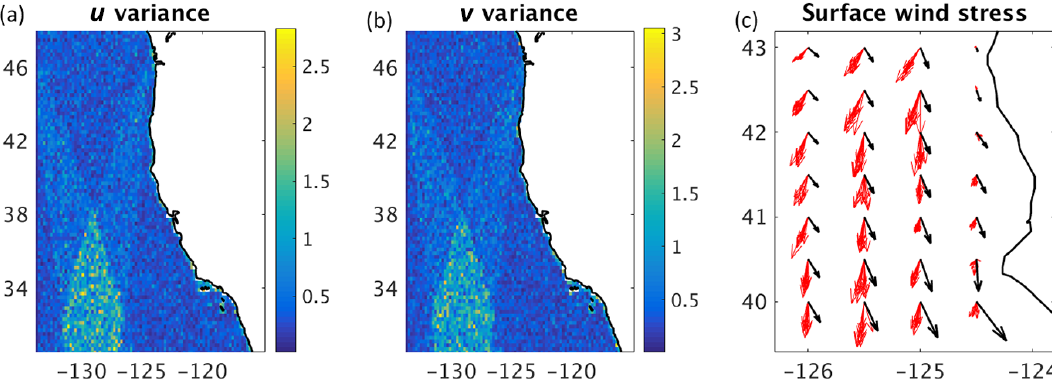
Figure 9. CCS surface wind BHM posterior distribution summaries for 19 January 2003. Velocity component variances (m 2 s − 2 ) for (a) u and (b) v as estimated in the BHM posterior distribution. Uncertainties, expressed as variances, arise from data stage coverage (swath patterns are evident in a and b ) and from process model misfits. The spread in velocity vector clusters (red) in (c) provides an intuitive sense of these uncertainties as well. In (c) , 10 surface wind realizations (red) have been randomly selected from the posterior distribution (e.g., see Milliff et al., 2011) in the same subdomain used for Fig. 8. Posterior wind vectors from the 4D-Var are shown in black in panel (c) . The strong- constraint 4D-Var corrections have incrementally adjusted the surface wind forcing to unrealistic values outside the distribution obtained from the BHM for this region (see